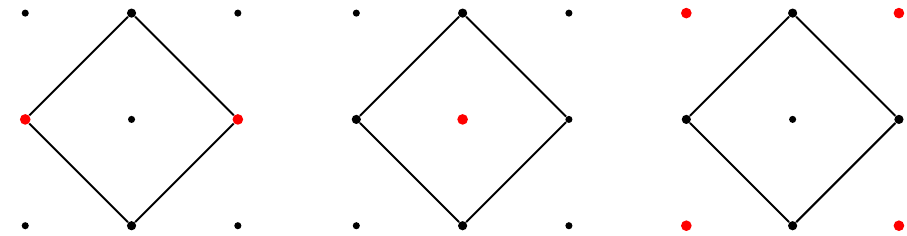
. Since Seiberg duality 2